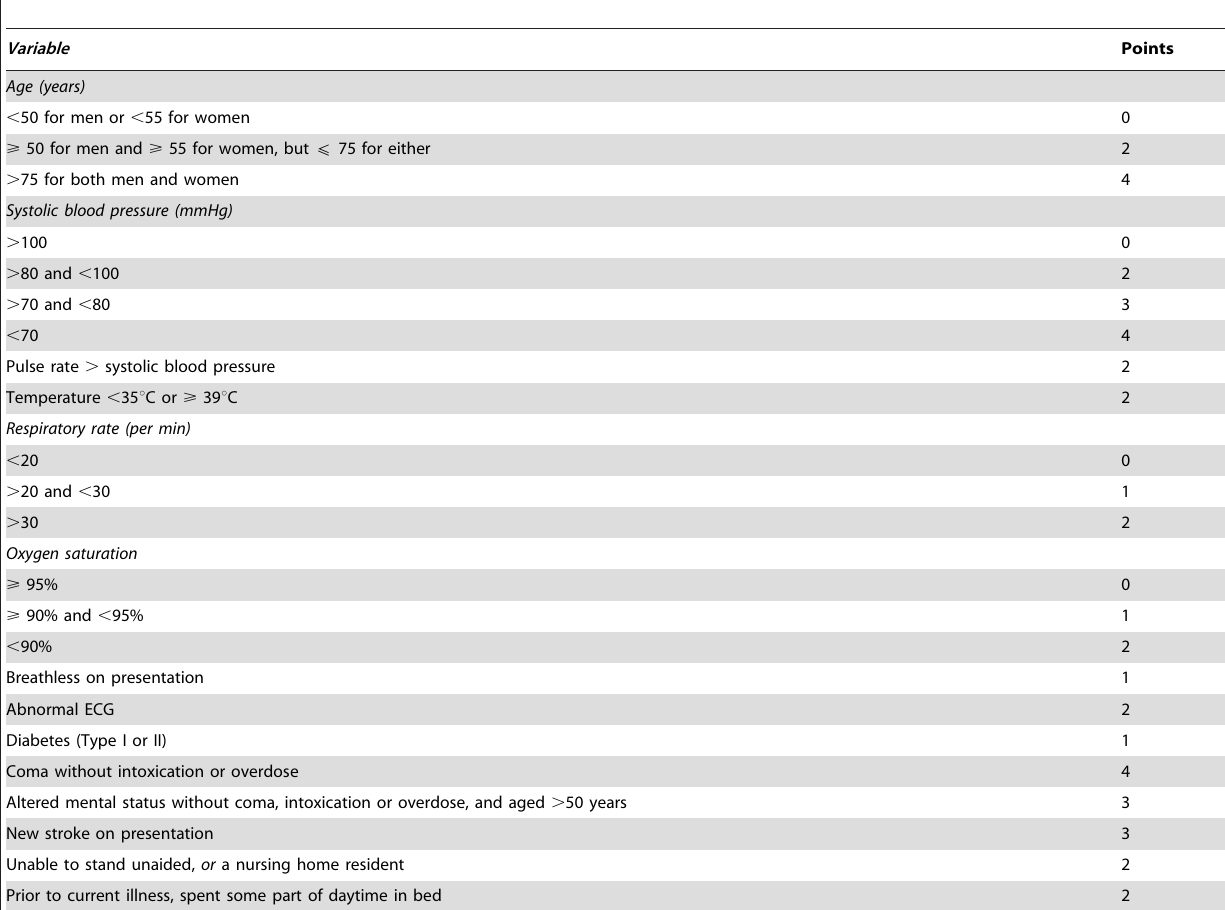
Table 1. The Simple Clinical Score.